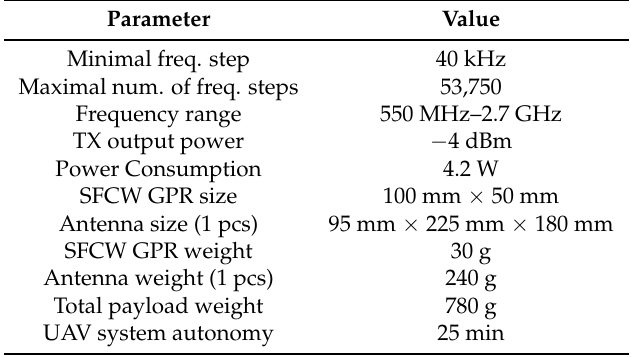
Table 1. Summary of SFCW GPR and Unmanned Aerial Vehicle (UAV)